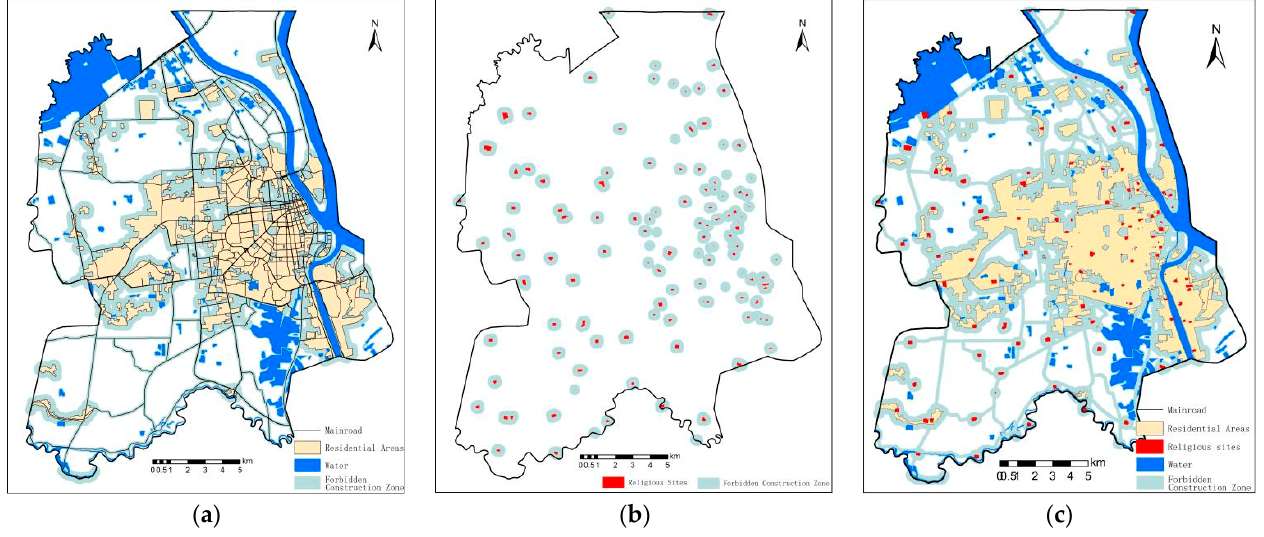
Figure 3. Buffer zone: ( a ) Buffer zone without religious POI; ( b ) Religious POI buffer zone; ( c ) Total forbidden construction zone.